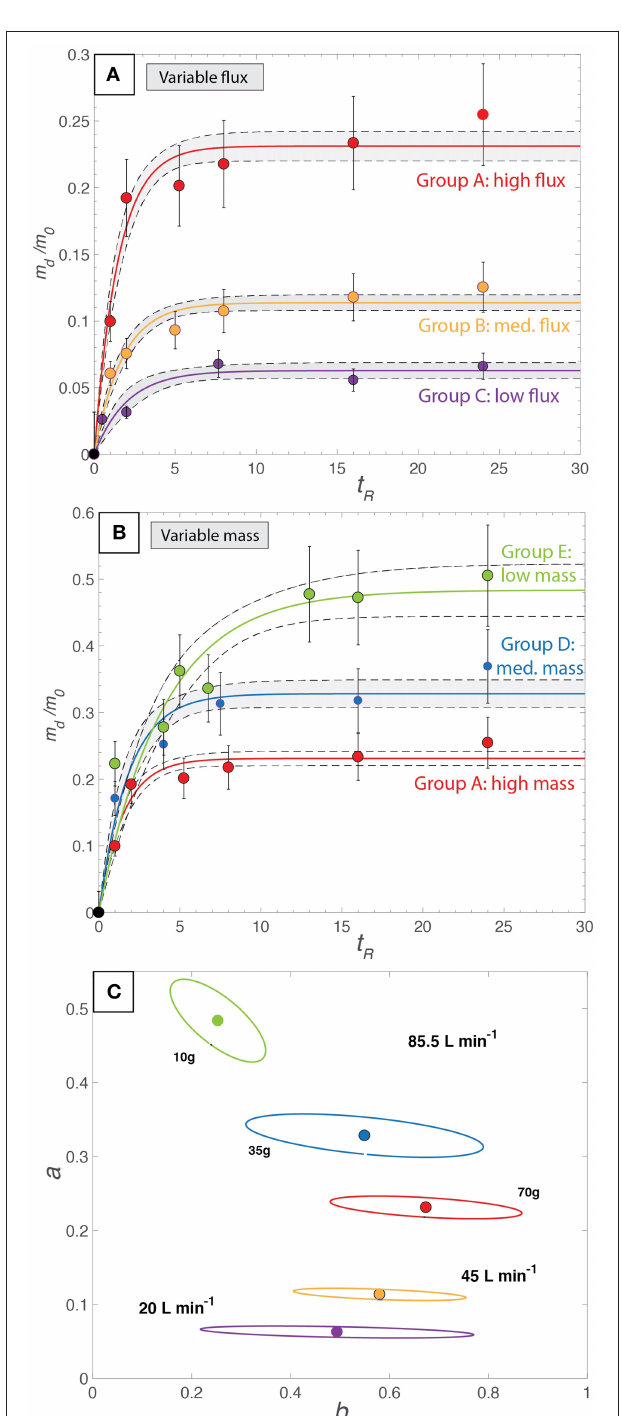
FIGURE 6 | Results of attrition experiments. Mass of the daughter products ( m d ) produced by attrition normalized to the initial mass ( m 0 ) as a function of residence time ( t R ) for experiments using different (A) gas fluxes, and (B) input masses. Solid curves are modeled using the empirical relationship: m d / m 0 a (1-e) − b t after Jones et al. (2017). (C) The model values of infinite time production limit, a , and the attrition rate constant, b for all experiments. The ellipses represent a 95% confidence envelope based on the fit of Equation 1 to our data. Color coding is consistent with Figure 5 .